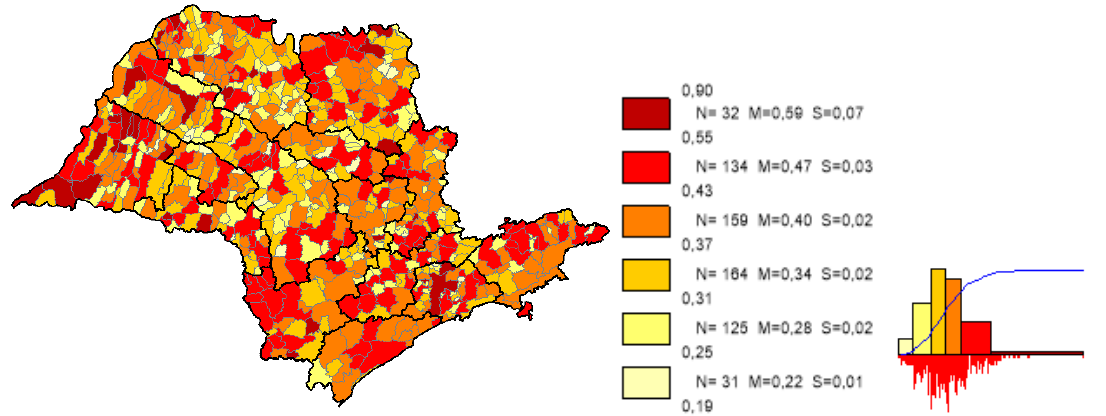
Figure 11. Distribution of inequity regarding work income distribution (Theil work) in the munici- palities of the state of SP. Note: Choropleth maps, consisting of six divisions, using the following limits—minimum value; 5th percentile; 25th, 50th and 75th percentiles; 95th percentile and maxi- mum value. For each interval, the number (N) of municipalities, their mean (M) and standard devi- ation (S) are described. The histograms contain bars proportional to the number of localities in each division ( Philcarto images).